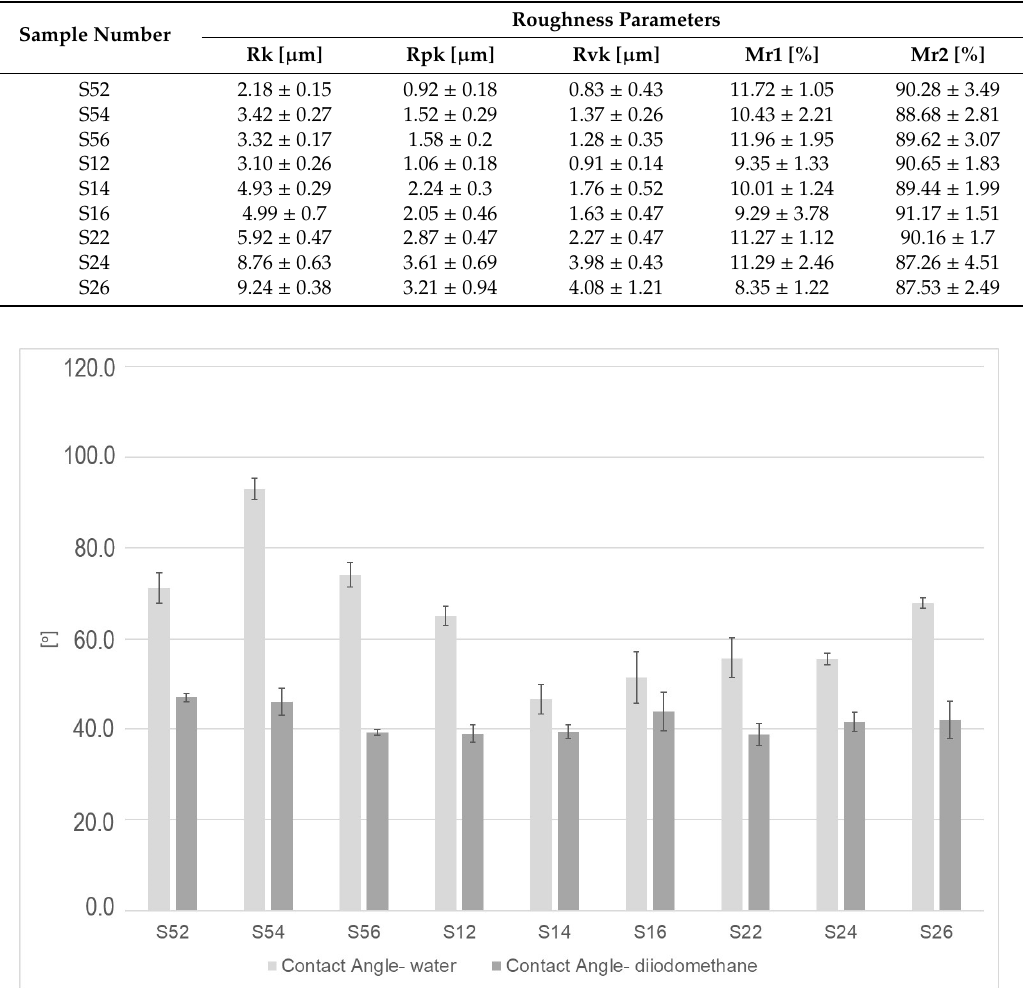
Figure 4. Material ratio curve in the profile of sample S24. Table 5. The results for the material percentage in the profile.